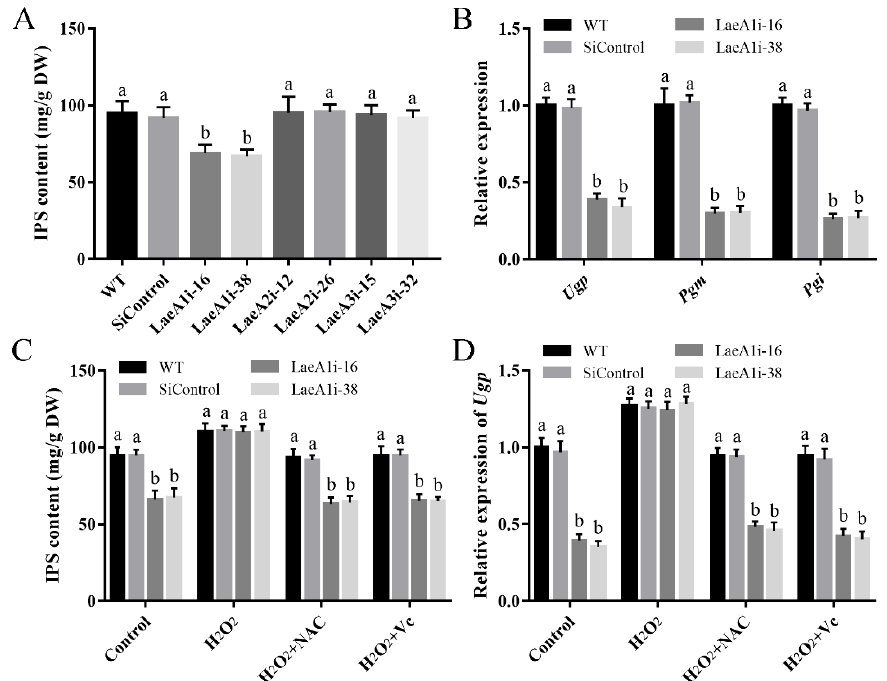
Figure 7. The intracellular ROS level was involved in the regulation of intracellular polysaccharide (IPS) content by PoLaeA1 . The P. ostreatus strains were cultured in liquid CYM treatment with or without 1 mM H 2 O 2 , 1 mM NAC or 1 mM Vc at 28 °C for 7 days. ( A ) IPS content of the PoLaeA -silenced strains. ( B ) Transcriptional analysis of polysaccharide biosynthesis-related genes. ( C ) H 2 O 2 recovered the decreased IPS content in the PoLaeA1 -silenced strains. The IPS contents in the fungal mycelia were measured with the phenol-sulfuric acid method using glucose as a standard. ( D ) Transcriptional analysis of Ugp . The expression level of the Ugp gene in the WT strain of the control was arbitrarily set to 1.0. The values are the mean ± SD ( n = 3). Different lowercase letters indicate significant differences between the strains ( p < 0.05, according to Dunnett’s multiple comparisons test).